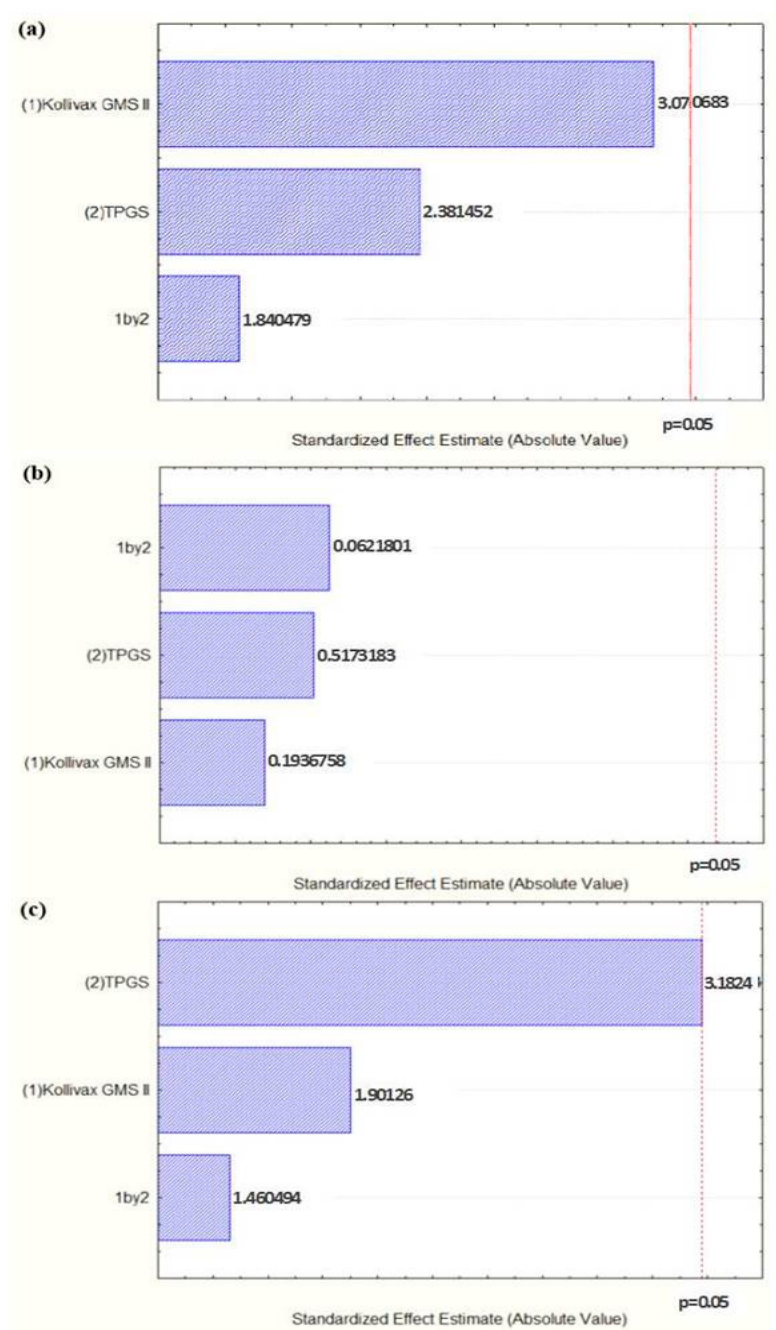
Figure 1. Pareto charts showing the effect of the concentration variation of the solid lipid (1), surfactant (2) and the interaction of both (1 by 2) on the sucupira oil-loaded NLC ( a ) mean particle size, ( b ) PI and ( c ) ZP.